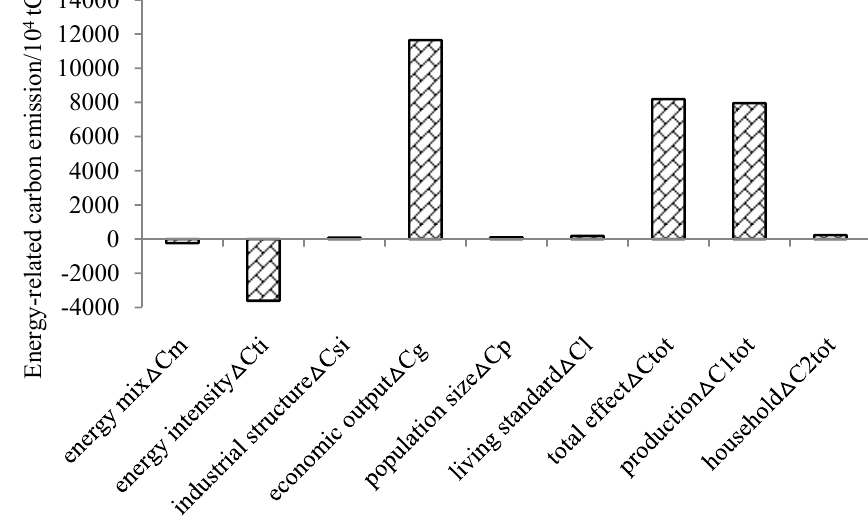
Figure 5. The contribution of each decomposition